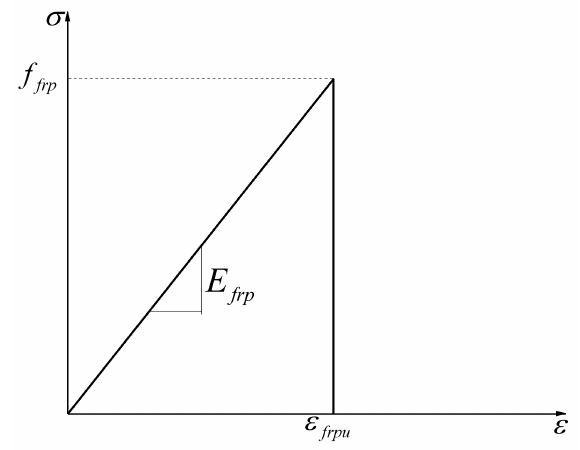
Figure 14. Constitutive relationship of fiber-reinforced polymer (FRP)